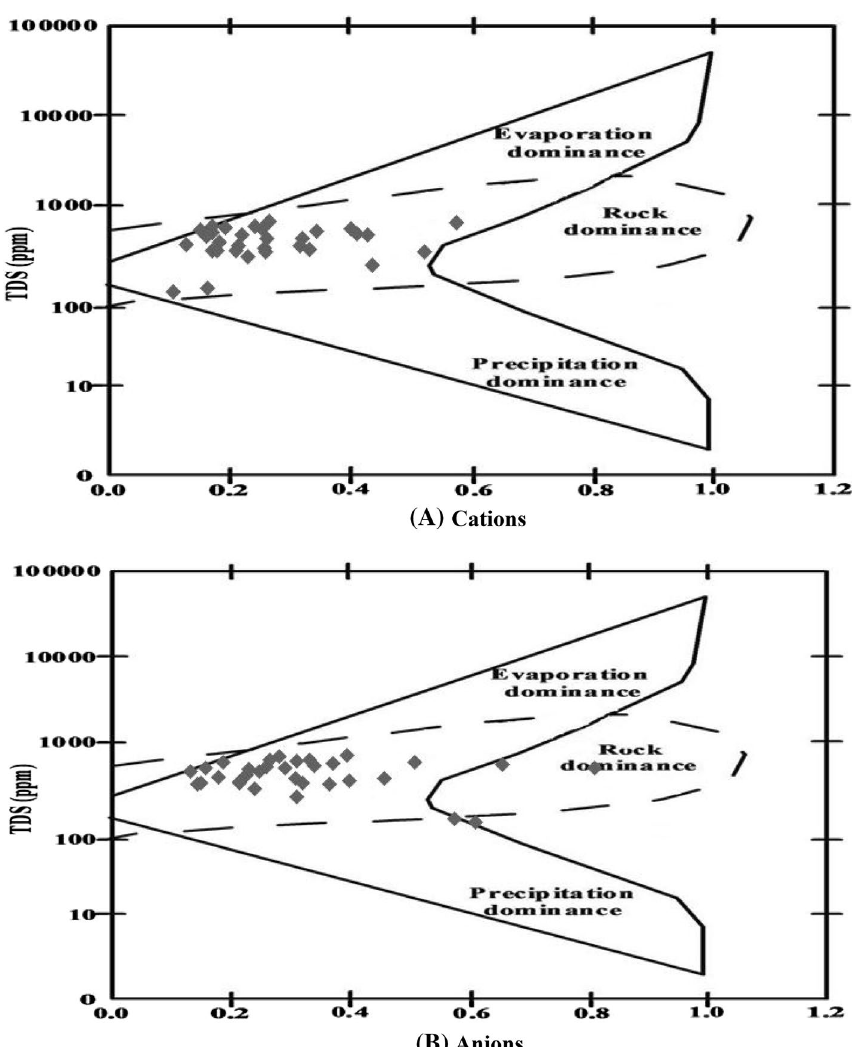
Fig. 35 Gibb’s diagram (post- monsoon), a Cations b